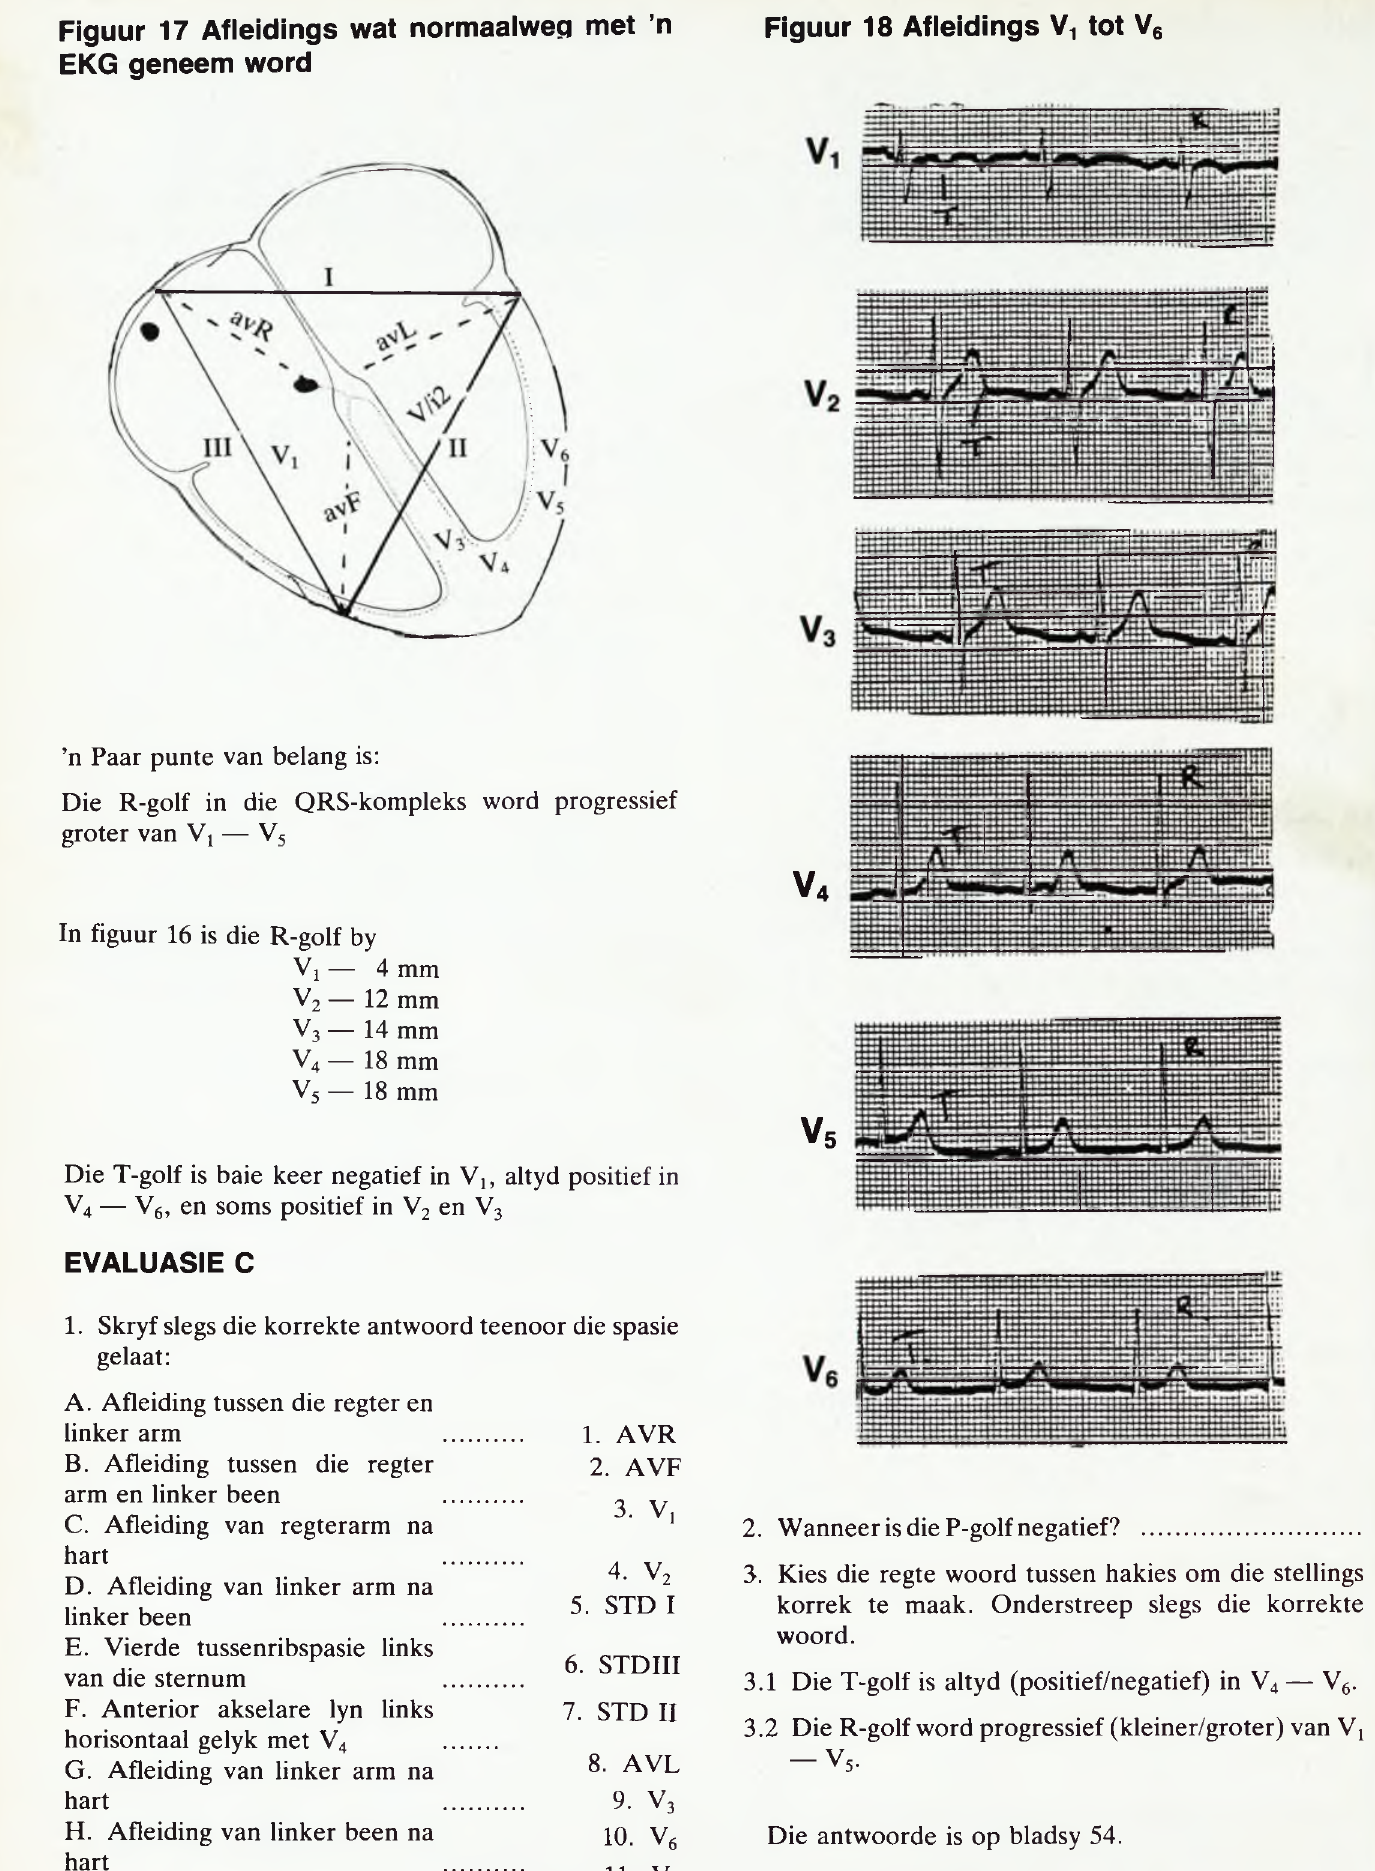
Figuur 18 Afleidings V, tot